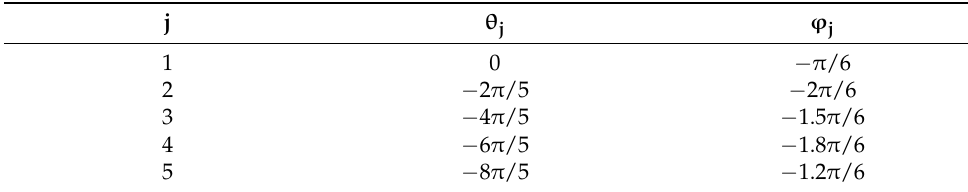
Table 3. Phase angles of line voltages and currents.